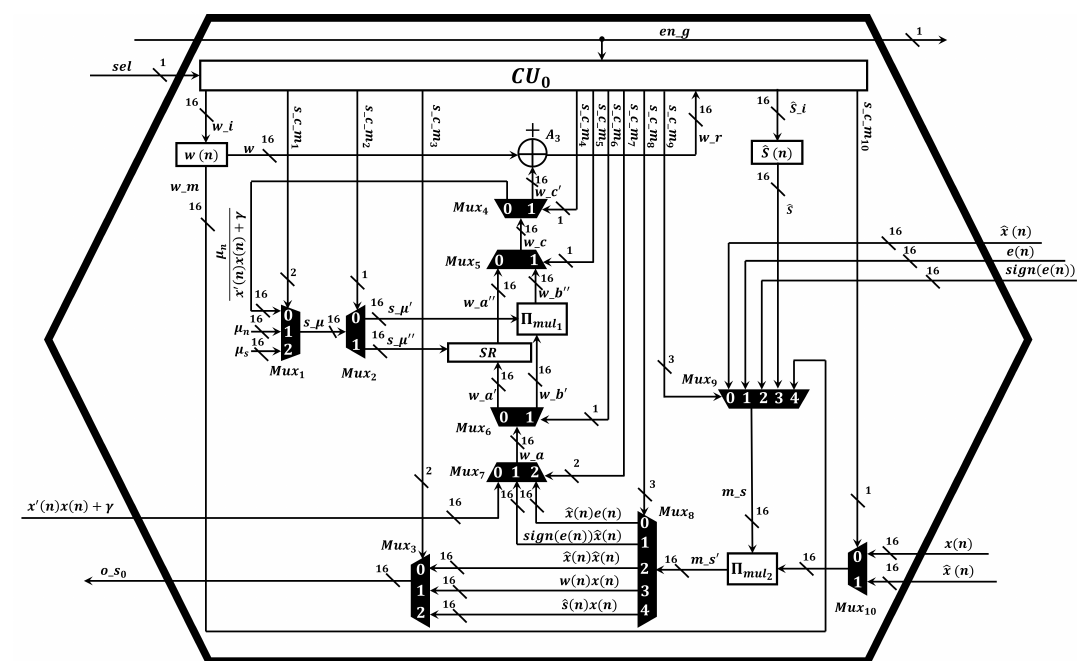
Figure 5. Structure of the dual adaptive